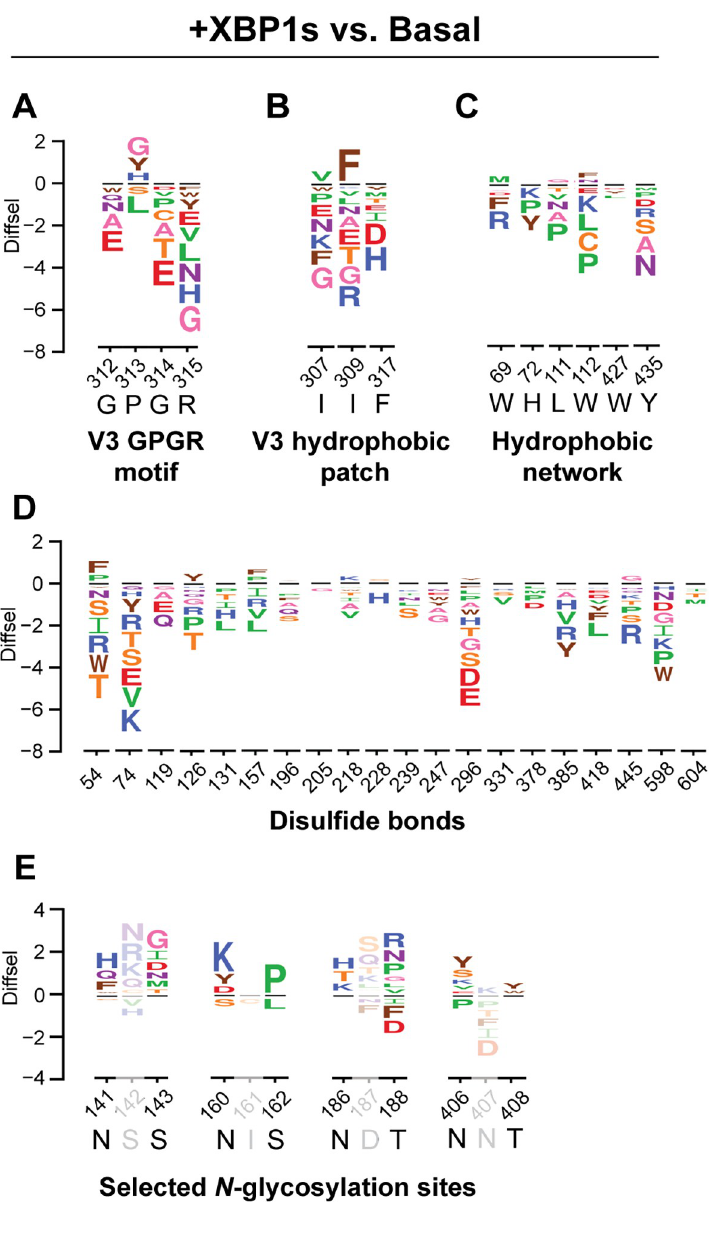
Fig 6. Diverse functional elements of Env respond differently to XBP1s induction. Selected sequence logo plots for the +XBP1s endoplasmic reticulum (ER) proteostasis environment normalized to the basal ER proteostasis environment for (A) the conserved GPGR motif of the V3 loop, (B) the hydrophobic patch of the V3 loop, (C) the hydrophobic network of gp120 (important for CD4 binding), (D) cysteine residues participating in disulfide bonds, and (E) selected N -glycosylation sequons (N-X-S/T) that exhibited positive net site differential selection (diffsel) in all 3 remodeled proteostasis environments. The height of the amino acid abbreviation corresponds to the magnitude of diffsel. The numbers and letters below the logos indicate the Env site in HXB2 numbering and the wild-type amino acid for that site, respectively. Only variants that were present in all 3 pre-selection viral libraries and exhibited diffsel in the same direction across the biological triplicates are plotted. All logo plots were generated on the same scale. Diffsel values are provided at https://github.com/yoon-jimin/2021_HIV_Env_DMS. Assignments of functional regions are provided in S2